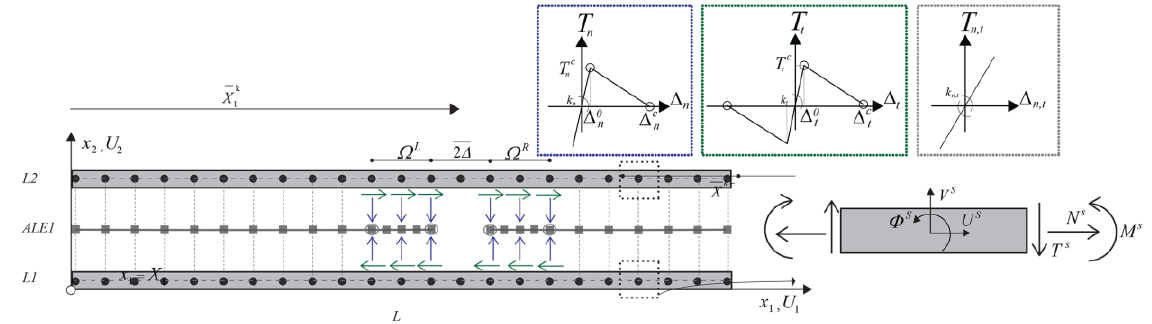
Fig.1. General representation of the laminate structure and of